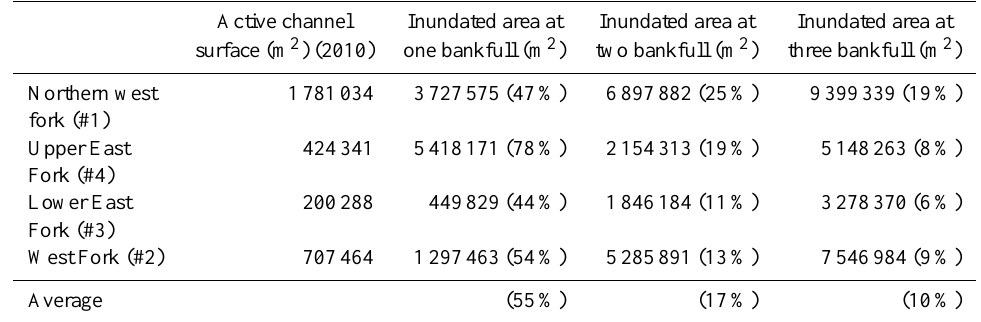
Table 1. Surface area (m 2 ) of the present day fluvial landscape in the Pas River at four locations (Fig. 1) is compared to the predicted fluvial landscape based on one, two and three bankfull depths. Values in ( ) indicate the percent remaining based on the present day Google Map images. Active channel Inundated area at Inundated area at Inundated area at surface (m 2 ) (2010) one bankfull (m 2 ) two bankfull (m 2 ) three bankfull (m 2